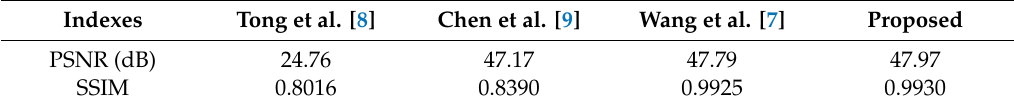
Figure 9. Tamper detection and recovery results of a splicing attack on the Car2 image: ( a ) original image; ( b ) watermarked image; ( c ) tamper reference; ( d ) tampered image; ( e ) tamper detection result of [8]; ( f ) tamper detection result of [9]; ( g ) tamper detection result of [7]; ( h ) tamper detection result of the proposed method; ( i ) recovery result of [8]; ( j ) recovery result of [9]; ( k ) recovery result of [7]; ( l ) recovery result of the proposed method. Table 4. Objective comparison of the recovery performances for a splicing attack on the Car2 image.